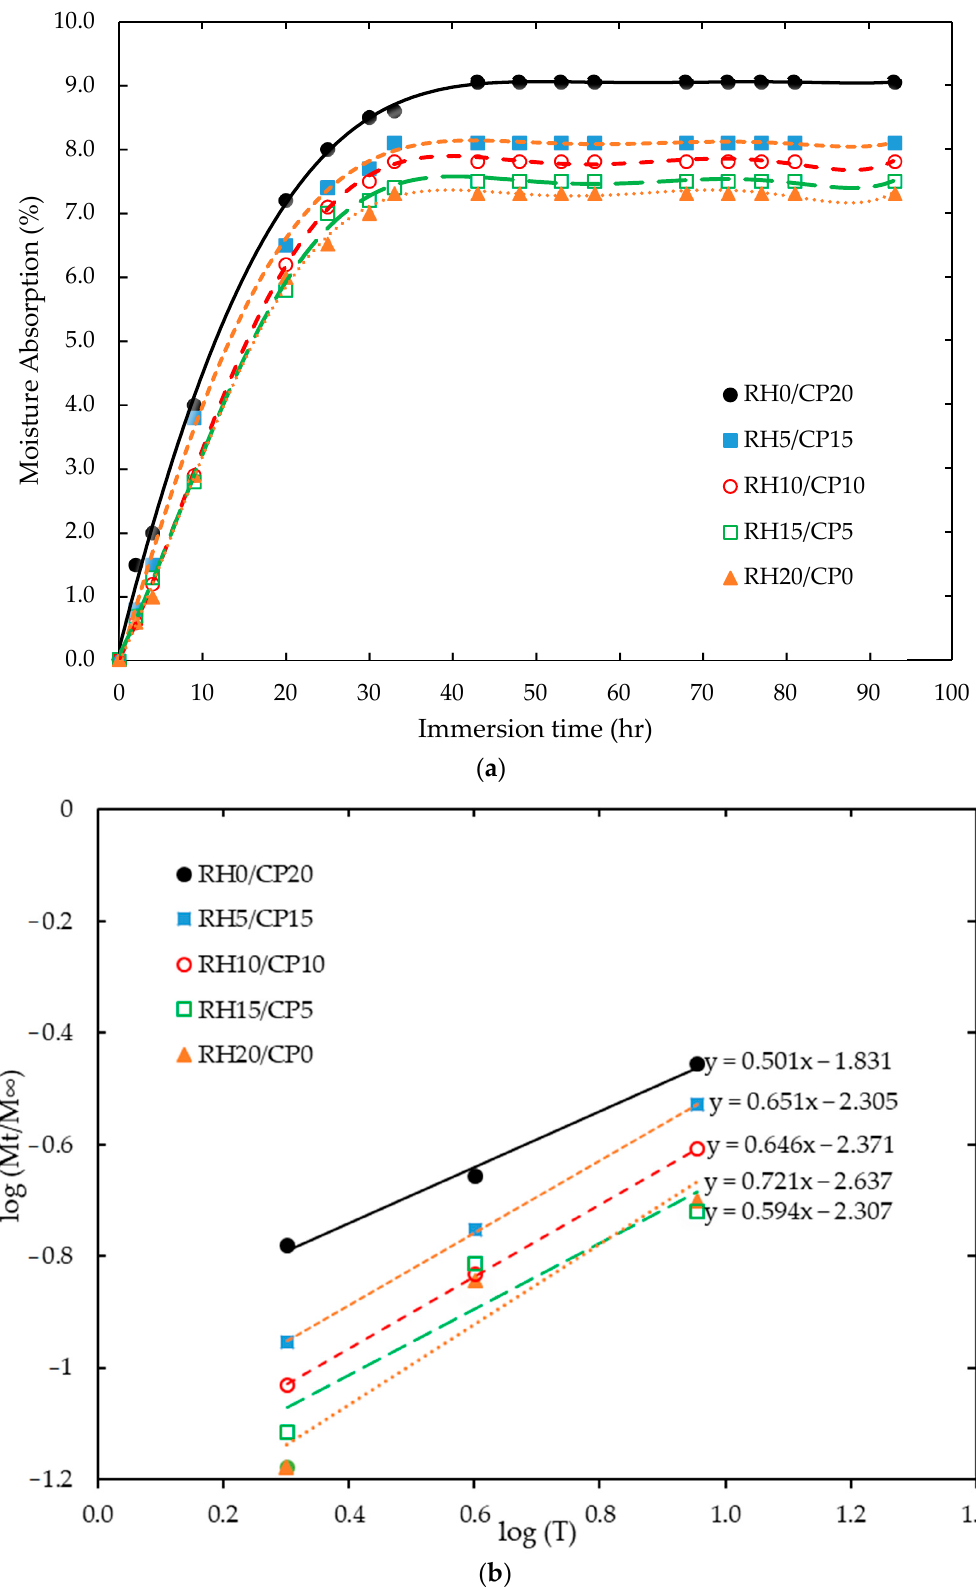
Figure 2. Typical ( a ) moisture absorption characteristics and ( b ) plot of log M t / M ∞ versus log time of blend RH/CP reinforced ABS composites.